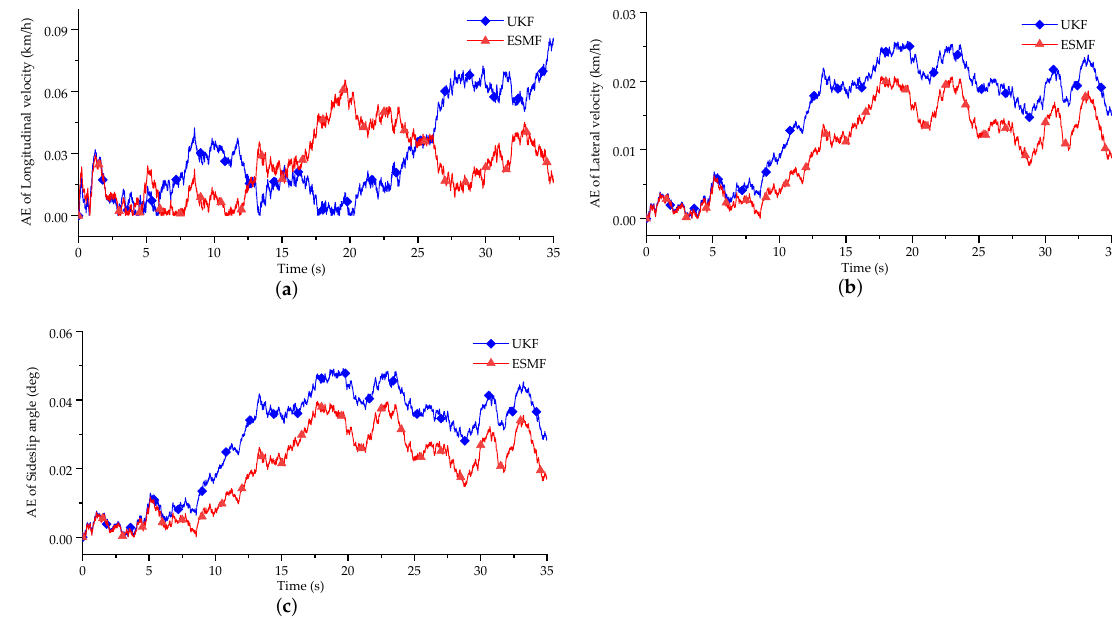
Figure 14. AE curves of two strategies under the slalom maneuver. ( a ) Longitudinal velocity; ( b ) Lateral velocity; ( c ) Vehicle sideslip